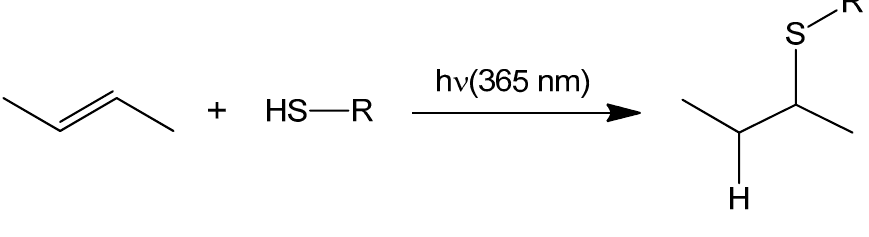
Table 3 summarizes results of the covalent linkage reaction of C14A with some metal- PPIXs. Table 3. Formation of the covalent linkage with different reconstituted proteins under the conditions employed in this study. ( ✓ ) The linkage formation is achieved; ( ) the linkage formation could not be achieved.